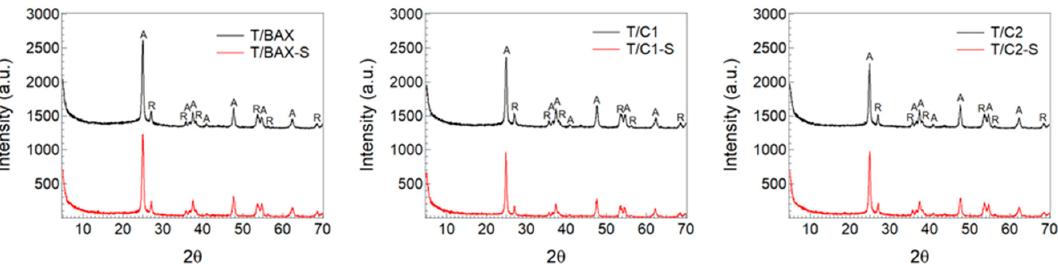
Figure 5. XRD diffraction patterns for the T/C hybrids studied.